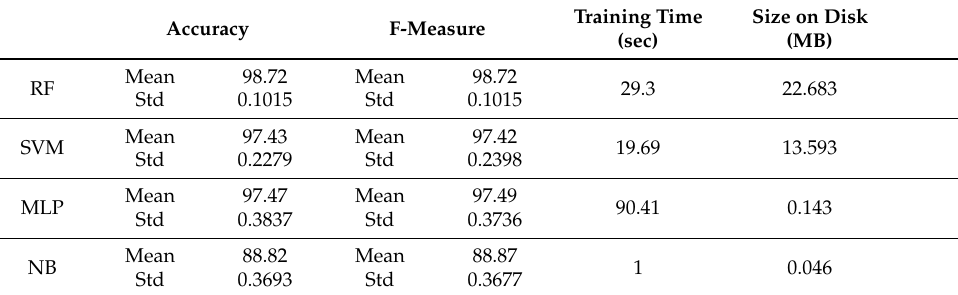
Table 4. Performance of compared classifiers for subject-dependent evaluation.